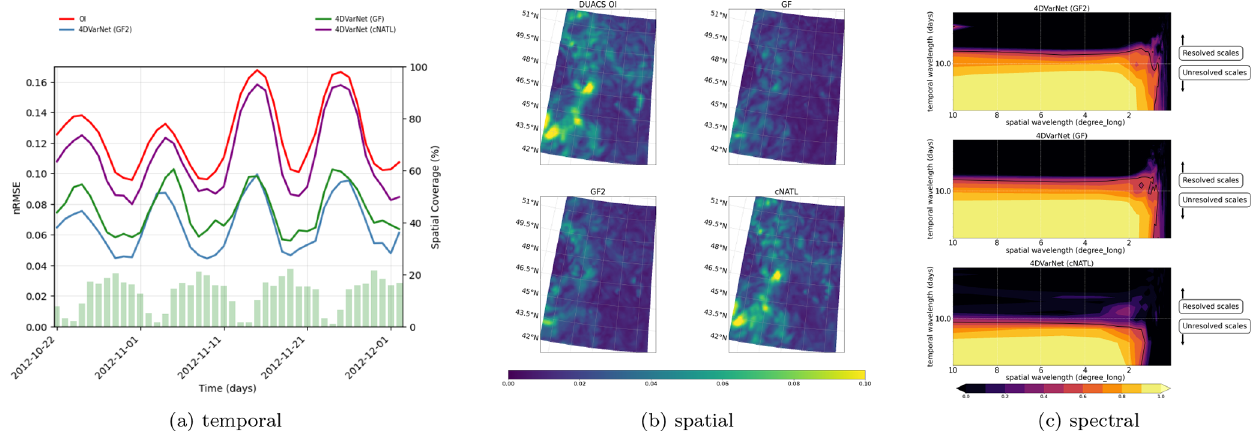
Figure B4. 4DVarNet generalization capabilities (GULFSTREAM2), with the spatial, temporal, and spectral performance on the BOOST- SWOT DC evaluation period, based on the three different training domains of GULFSTREAM2, GULFSTREAM, and cNATL.